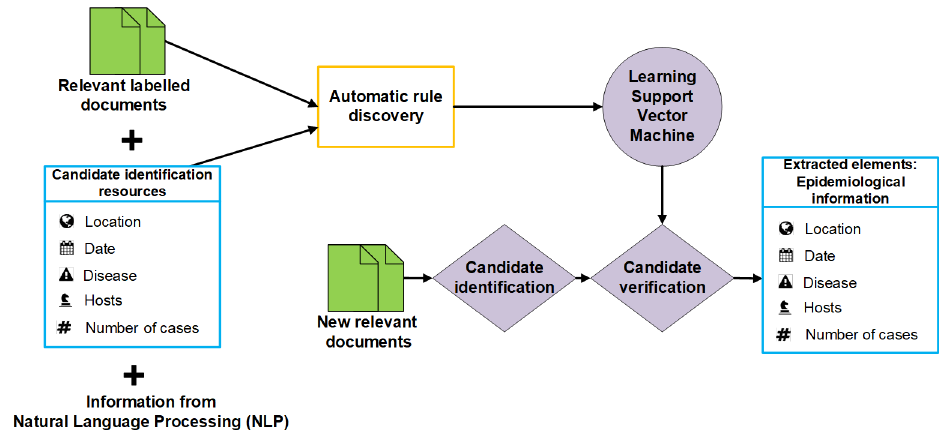
Fig 1. Information extraction step implemented in